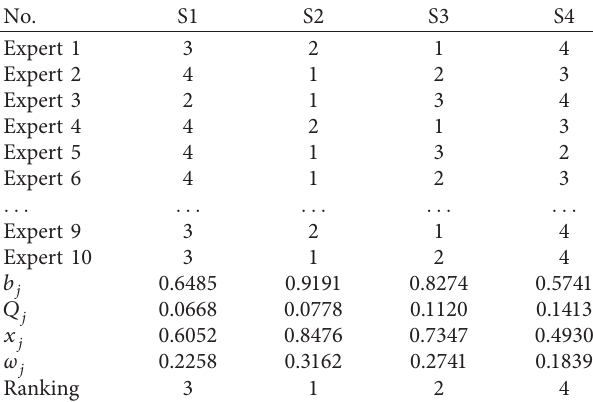
Table 6: The weights of 6 secondary indexes related to safety.